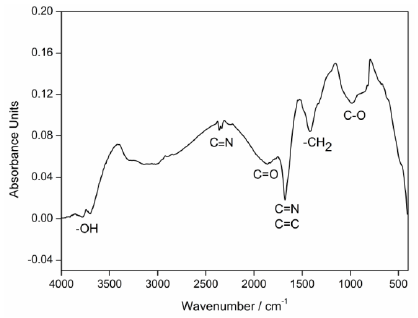
Figure 1. FT-IR spectrum of pre-oxidized PAN fibers.